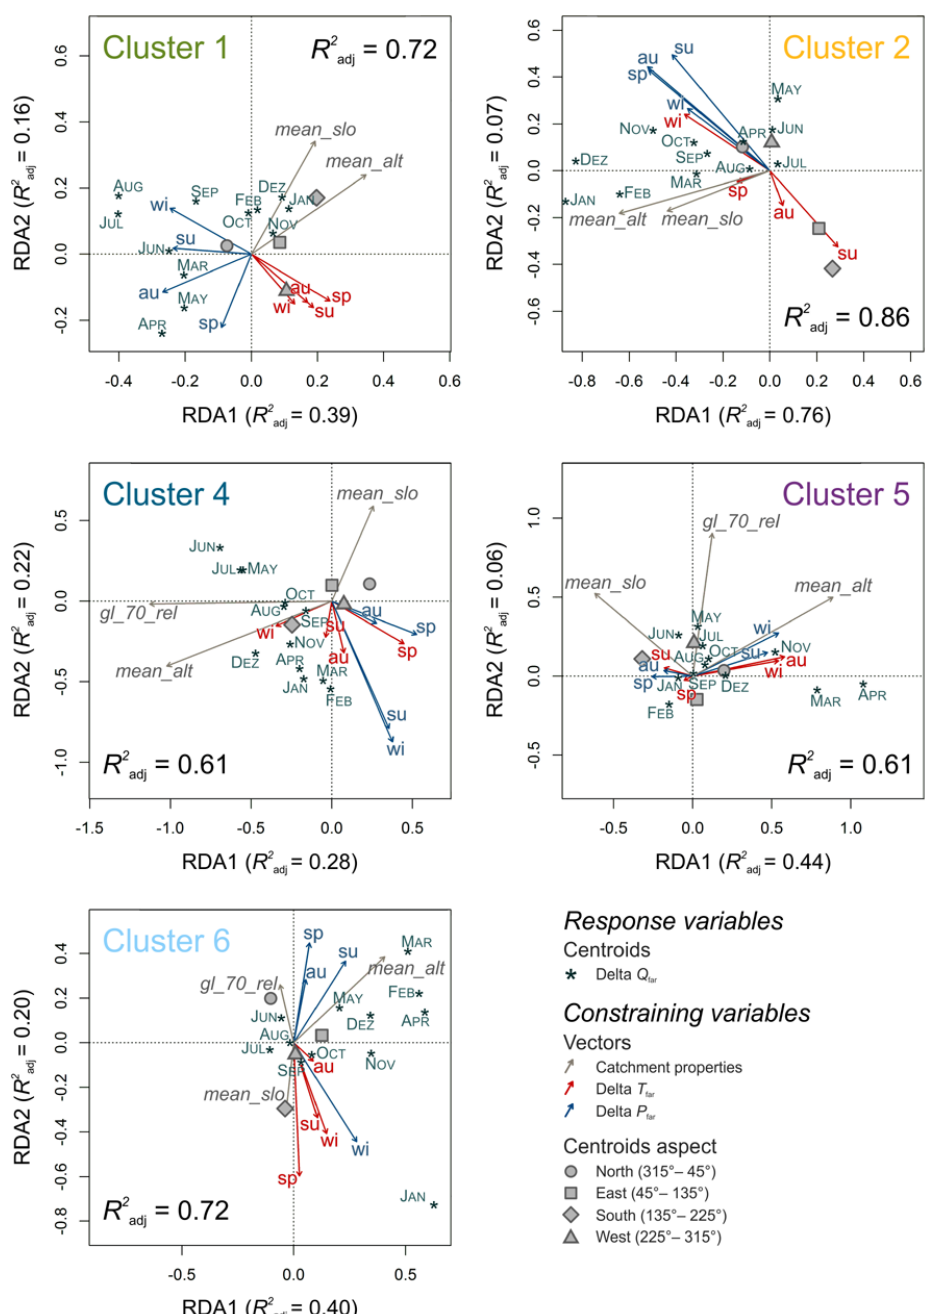
Fig. 7. RDA results for the far future period and single clusters. Clusters three and seven were not analysed because of their too small numbers of cluster members. For explanation of the vector names, see Fig. 6. Note that Clusters 1 and 2 are not glaciated and therefore miss glaciation as a constraining